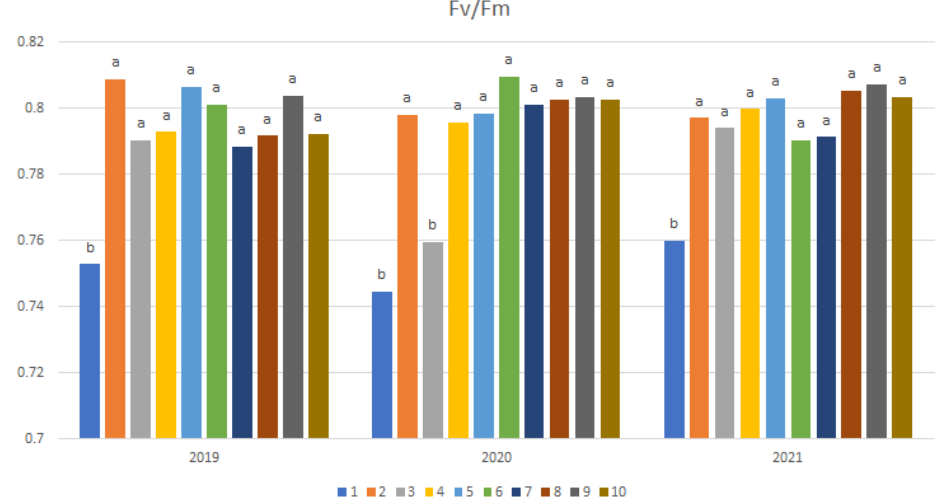
Figure 4. Fv (variable fluorescence) results for maize in individual years of research. Different let-ters indicate statistically different mean LSD (0.05): 2019 = 79.59; 2020 = 58.64; 2021 = 93.13. The combination numbers are as specified in Tables 5 and 6.